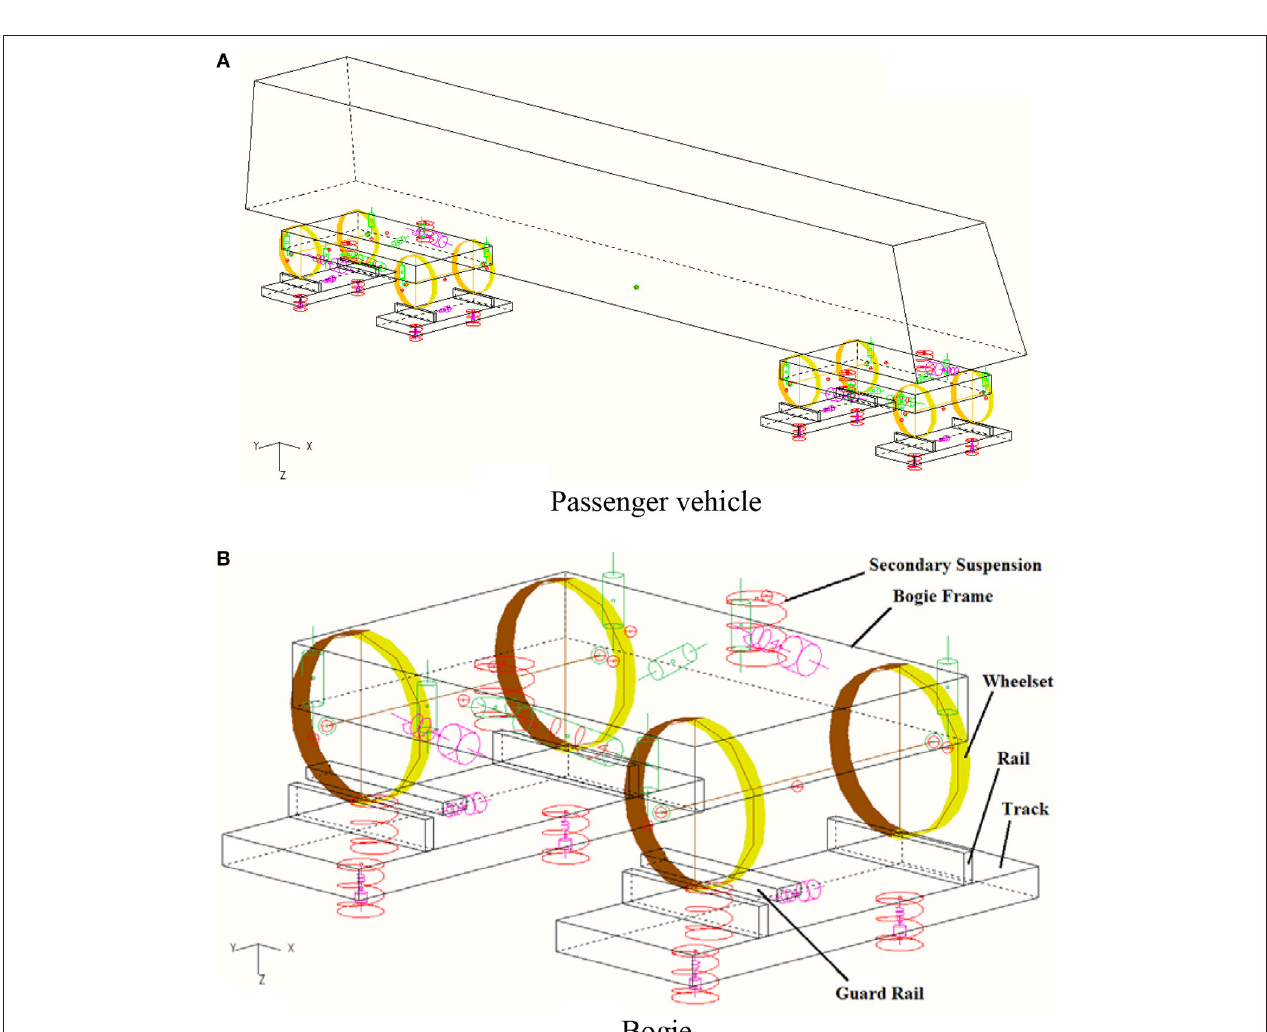
FIGURE 2 | Passenger vehicle model. Source: From Sun et al. (2017a). With permission of ASME publications.